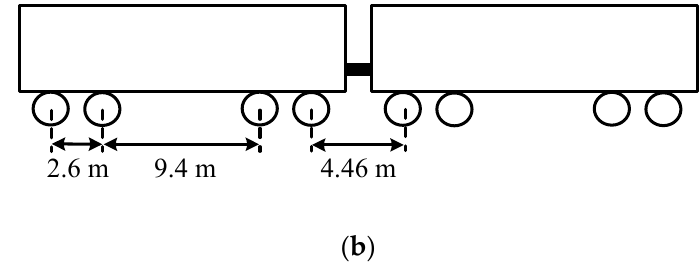
( b ) Figure 4. Target damage and experimental scheme: ( a ) target damage; ( b ) experimental scheme. Figure 5a,b shows the diagram and figure of the experimental system. The system was mainly composed of sensors, a conditioning module, a signal acquisition module and a PC. The professional acquisition device ART USB8514B was selected as the acquisition device in this system, which can realize four-channel synchronous sampling with 40 MSa/s. The sensor model was DS-1201 produced by TE Company; the length, width and height were all 8.9 mm, which made it easy to integrate with the switch rail base. The conditioning module was from the switch rail monitoring system developed by our group [31]. The sampling frequency was set to 10 kHz and the sampling time was 10 s. 3.2. Determining Passing Time and Correcting Velocity Taking the vibrations of the vehicle passing through the damage and nearby areas at 16 km/h (about 4.44 m/s) as an example, the time domain signals are shown in Figure 6. As shown in this figure, the signal-to-noise ratio of the original signals was low; hence, it was difficult to identify and extract the damage-induced impact vibration directly. Based on Zhai’s research [3] that rail joints can cause strong wheel–rail contacts and that the